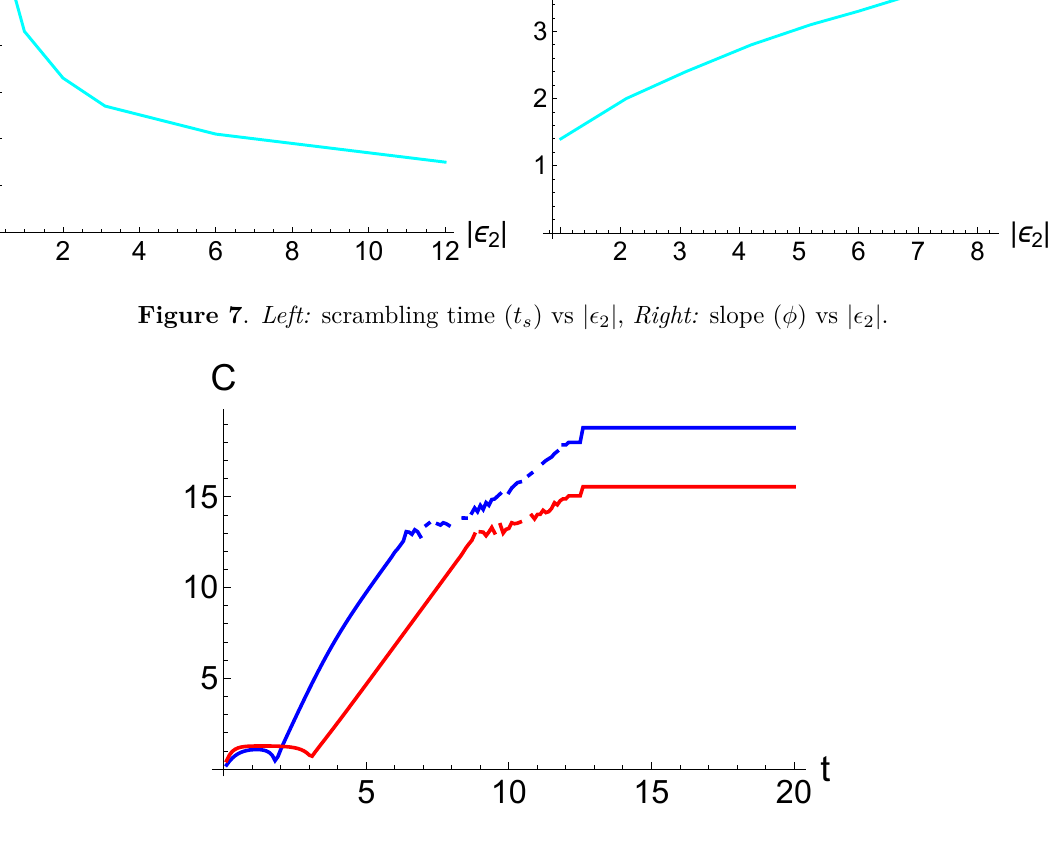
Figure 8 . Blue: (cid:15) 1 = − 2 . 3 , (cid:15) 2 = − 6 . 1 , λ = 0 . 1 , red: (cid:15) 1 = − 6 . 1 , (cid:15) 2 = − 2 . 3 , λ = 0 . 1